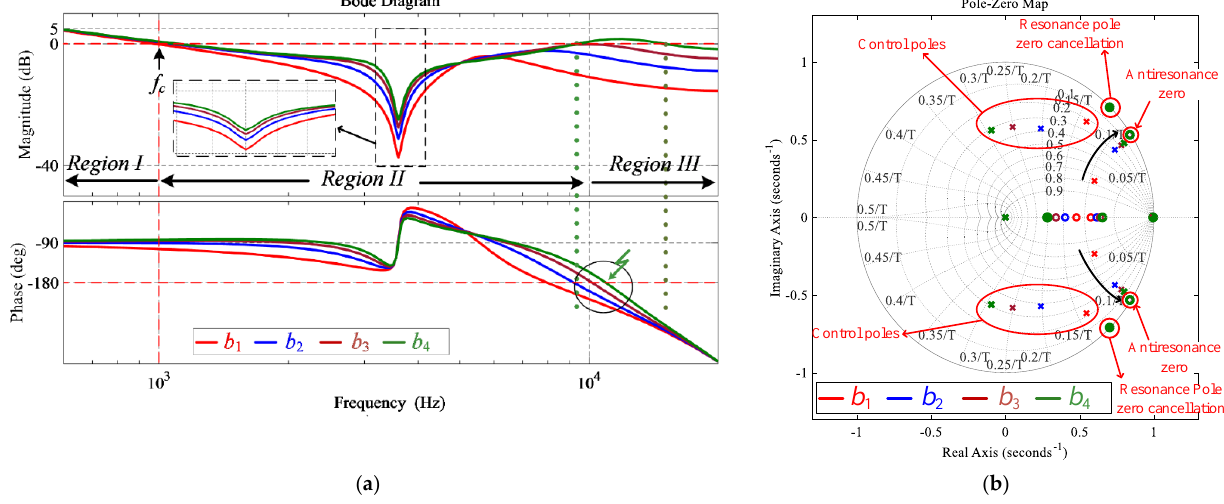
Figure 11. Loop gain frequency response using FESO-based ADRC for LCL filter type GcI under variation in gain parameter b ( a ) Using Bode Plots; ( b ) Using root loci.